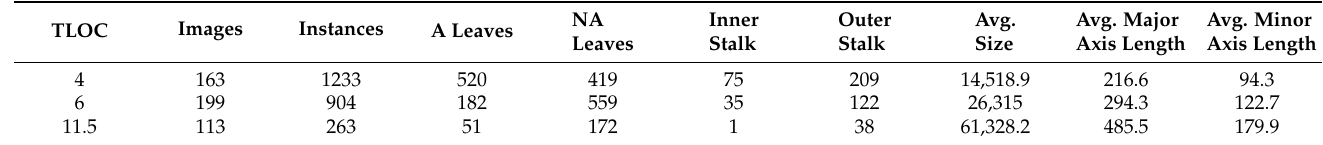
Table 2. Annotation statistics for the overlength dataset from